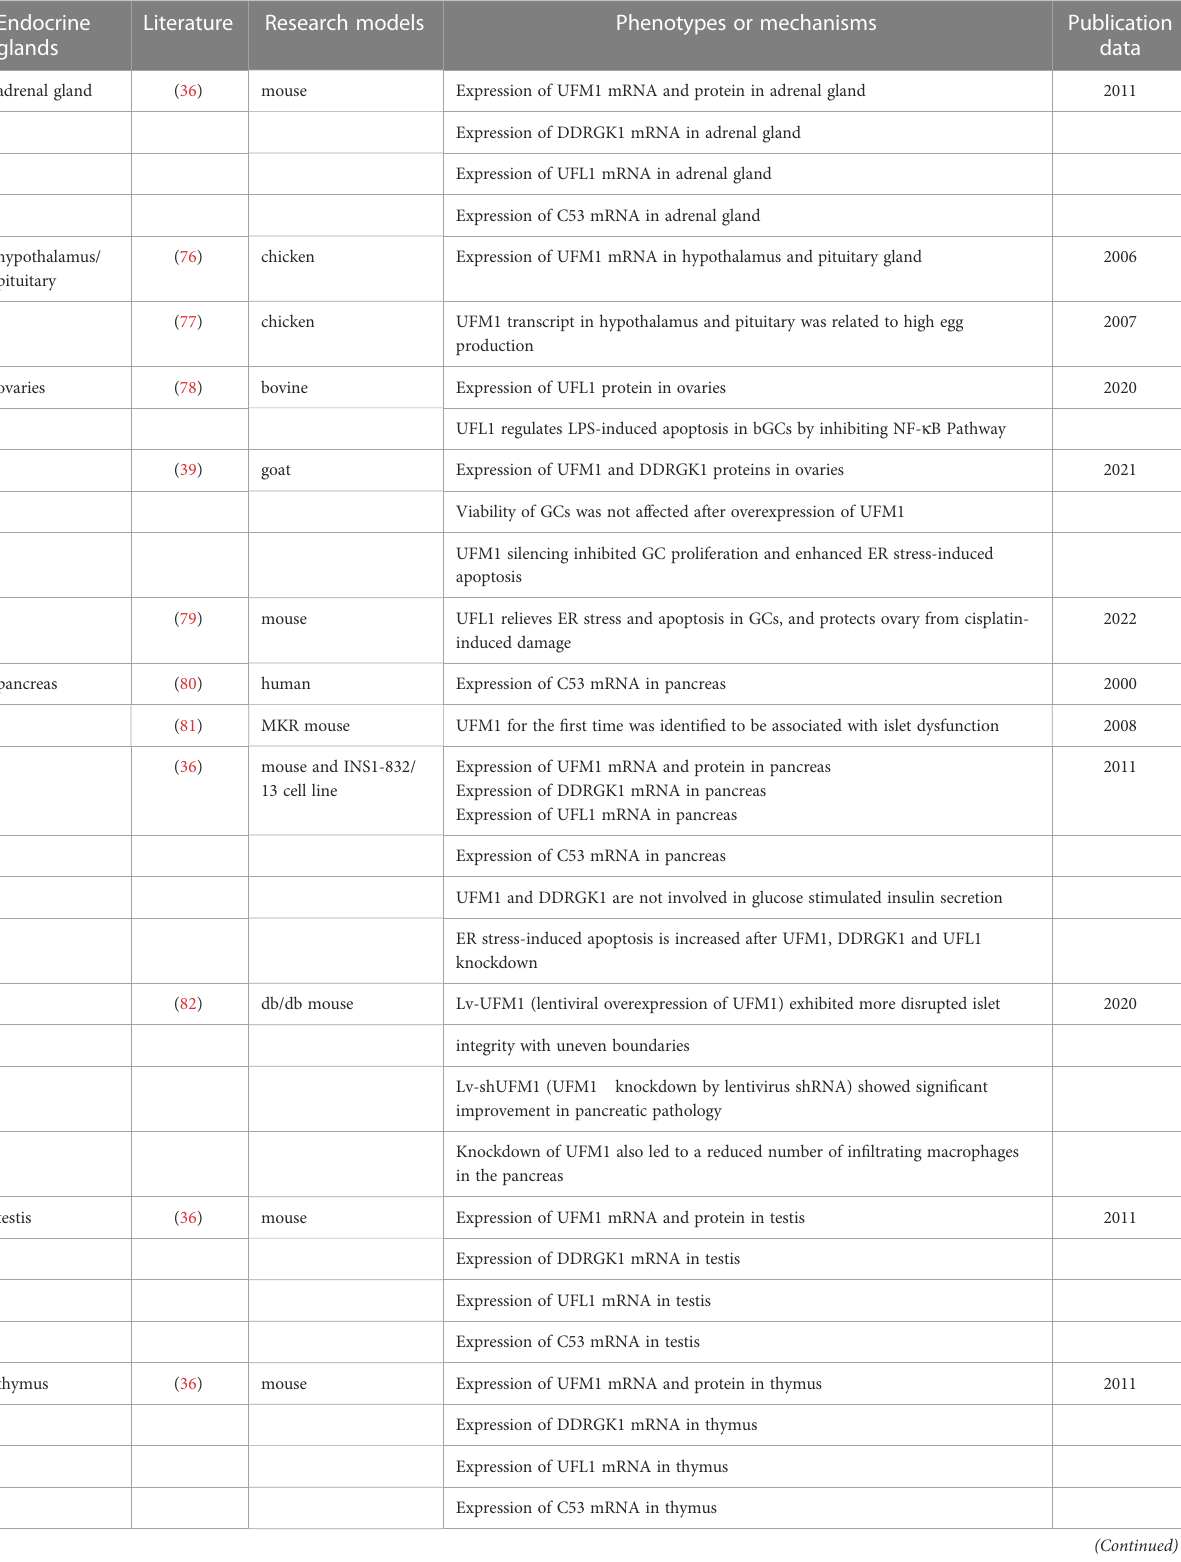
TABLE 2 Summary for UFMyation components in endocrine